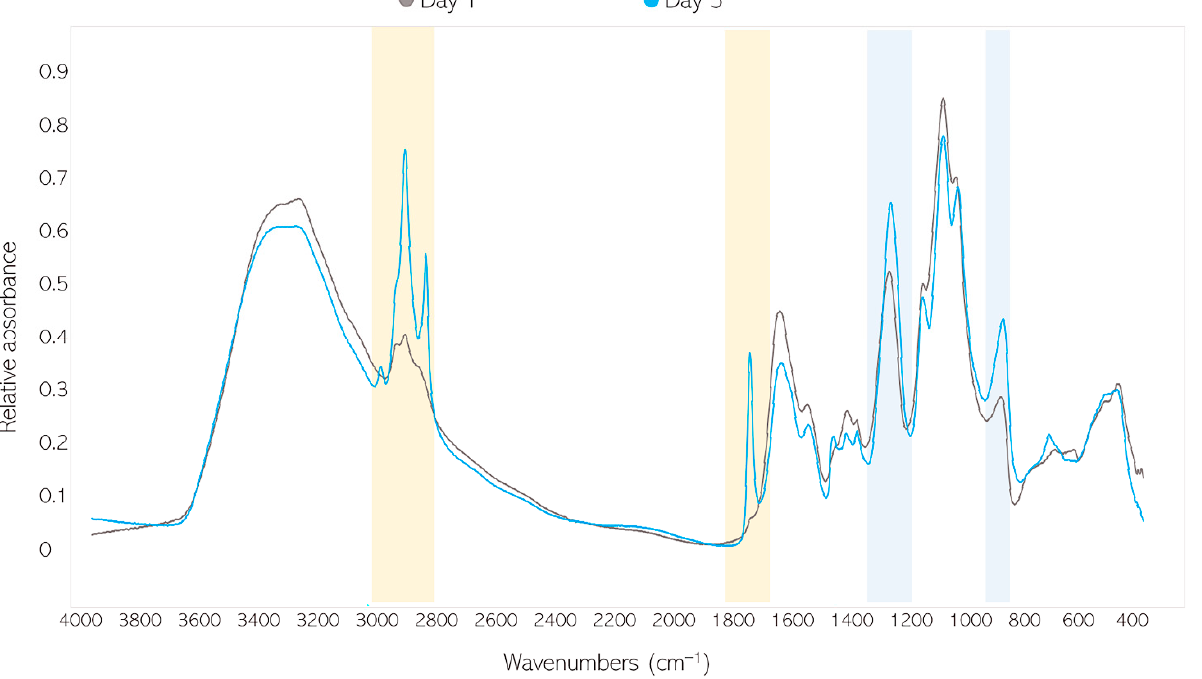
Figure 7. FTIR-HTS spectra of Mucor circinelloides VI 04473 biomass grown in Pi4-Ca1 media for 1 (grey) and 5 days (blue). Lipid-related peaks are highlighted in yellow; polyphosphate-related peaks are highlighted in blue.